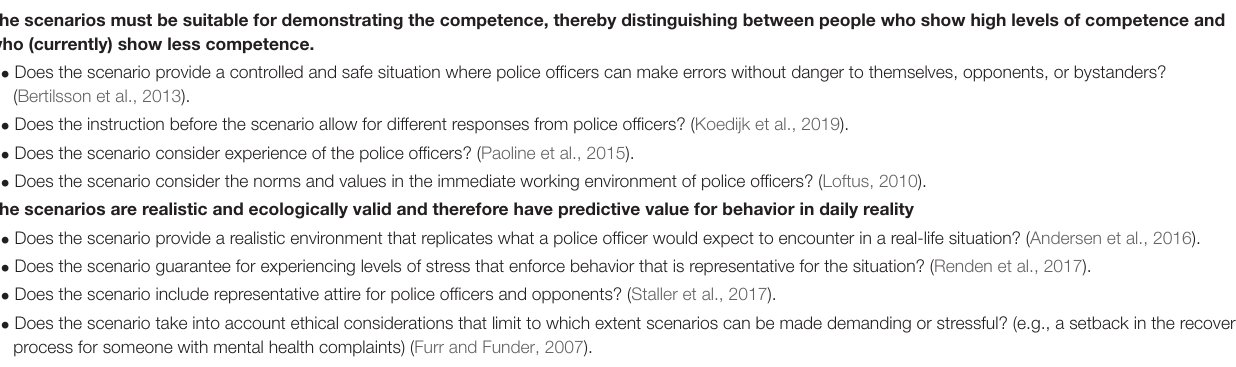
TABLE 3 | Sample questions police organizations can ask when choosing and designing relevant scenario-contexts. The scenarios must be suitable for demonstrating the competence, thereby distinguishing between people who show high levels of competence and who (currently) show less